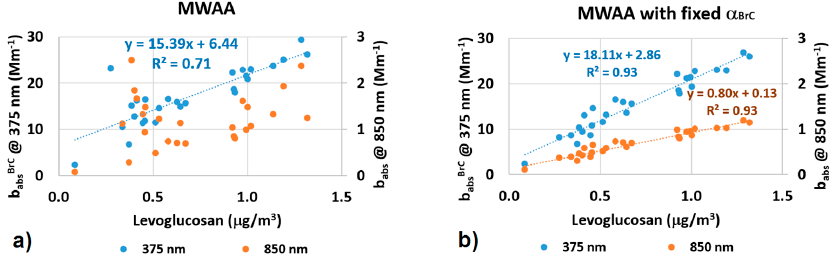
Figure 8. Scatterplot of b absBrC (375nm) and b absBrC (850 nm) vs. levoglucosan concentration in Milan obtained running: ( a ) the original MWAA model, ( b ) MWAA model with fixed α